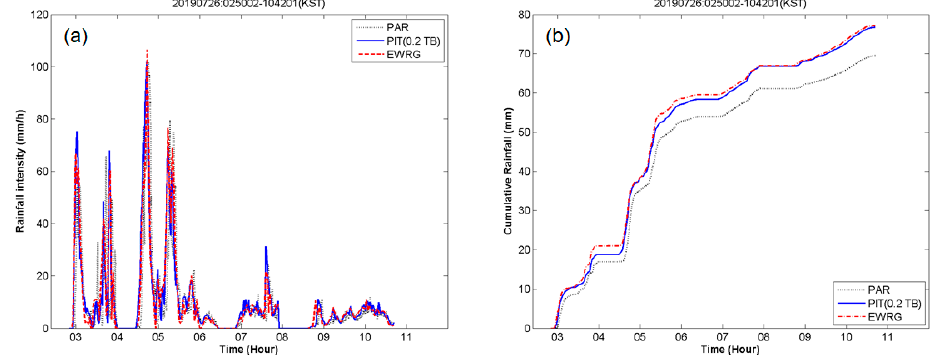
Figure 16. Comparison between results obtained for event 4: ( a ) EWRG average rainfall (mm / h) and rain gauge rainfall (mm / h); ( b ) cumulative EWRG average rainfall (mm) and cumulative rain gauge rainfall (mm). The red dotted line shows the average rainfall obtained by the EWRG, and the solid blue line and the black dotted line indicate rainfall measured by the pit-gauge and Parsivel disdrometer, respectively.